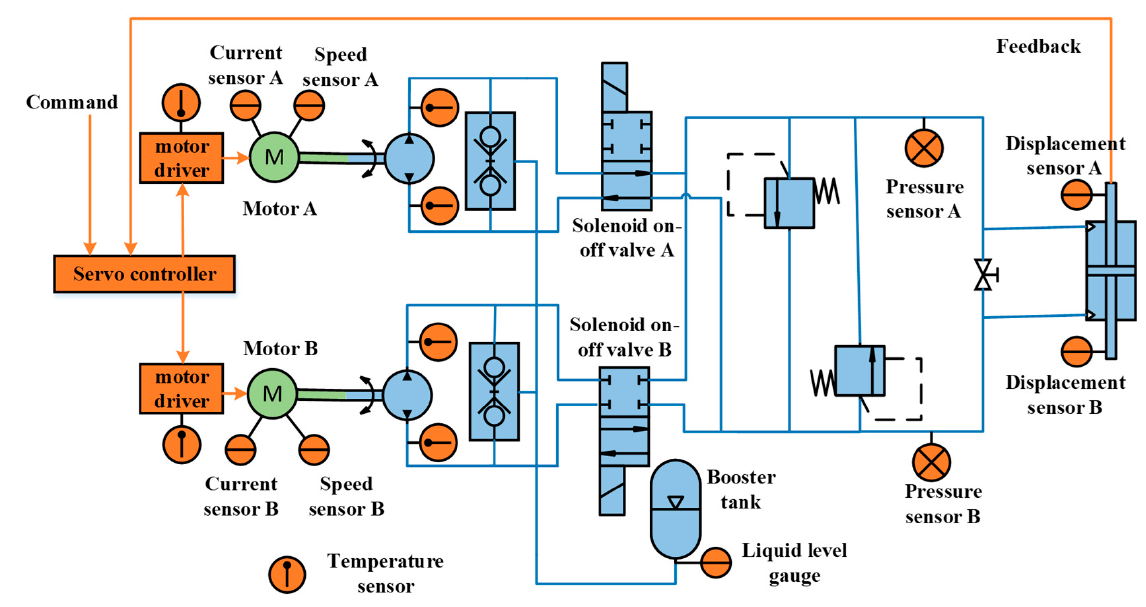
Figure 3. Structure diagram of the double redundancy EHA system.